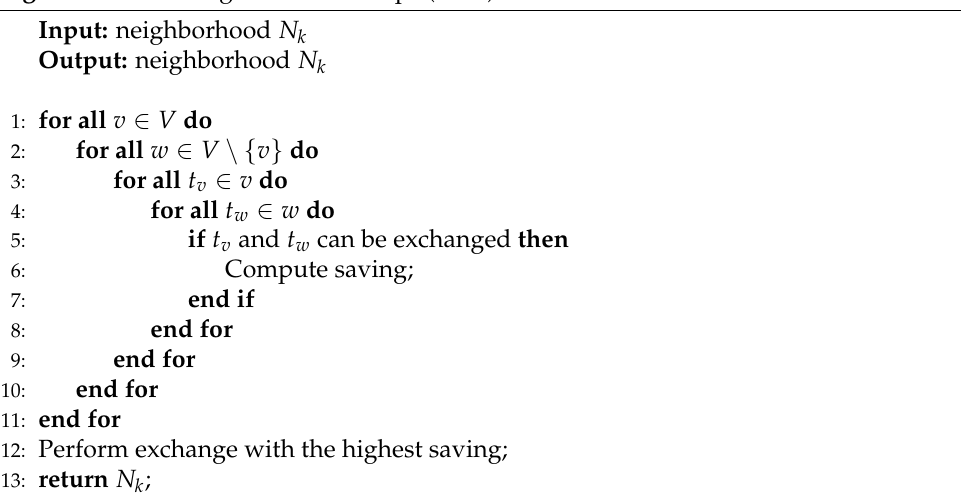
Algorithm 6 is used to reduce operational costs for deadheading by exchanging service trips between different vehicle rotations of a corresponding neighborhood. Therefore, a saving is computed for each pair of service trips for the neighborhood’s set of vehicles that can be exchanged, and the move with the highest saving is returned. Algorithm 6 Exchange of Service Trips ( EXST ).